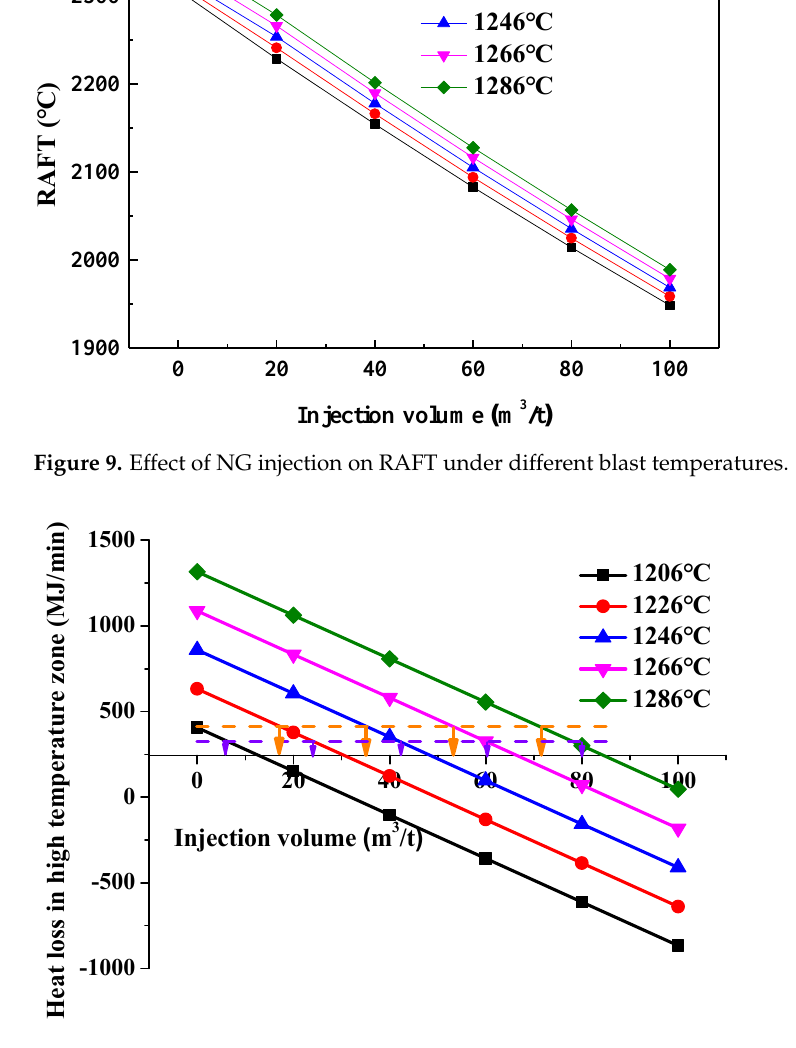
Figure 10. Effect of NG injection on heat loss in the high temperature zone of blast furnace under different blast temperatures.